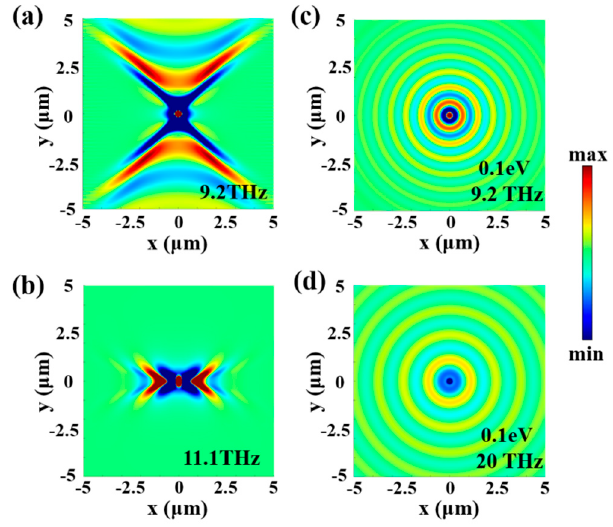
Figure 2. Predictions of THz polaritons in α -MoO 3 and graphene with hyperbolic and circular propagation, respectively. ( a , b ) Images of the real part of the near-field amplitude distribution (E z ) on top of a 20 nm α -MoO 3 film; ( c , d ) real part of E z on top of graphene under different excitation frequencies.